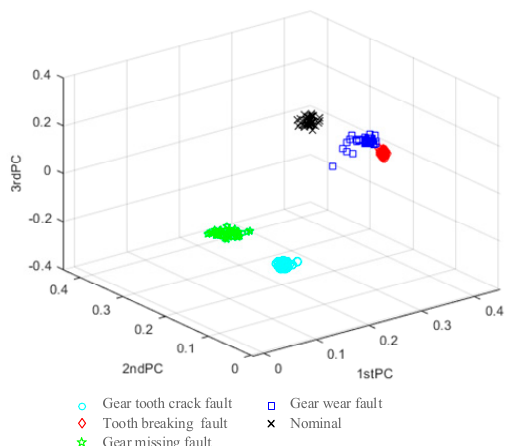
Figure 11. Clustering result of wavelet entropy under condition